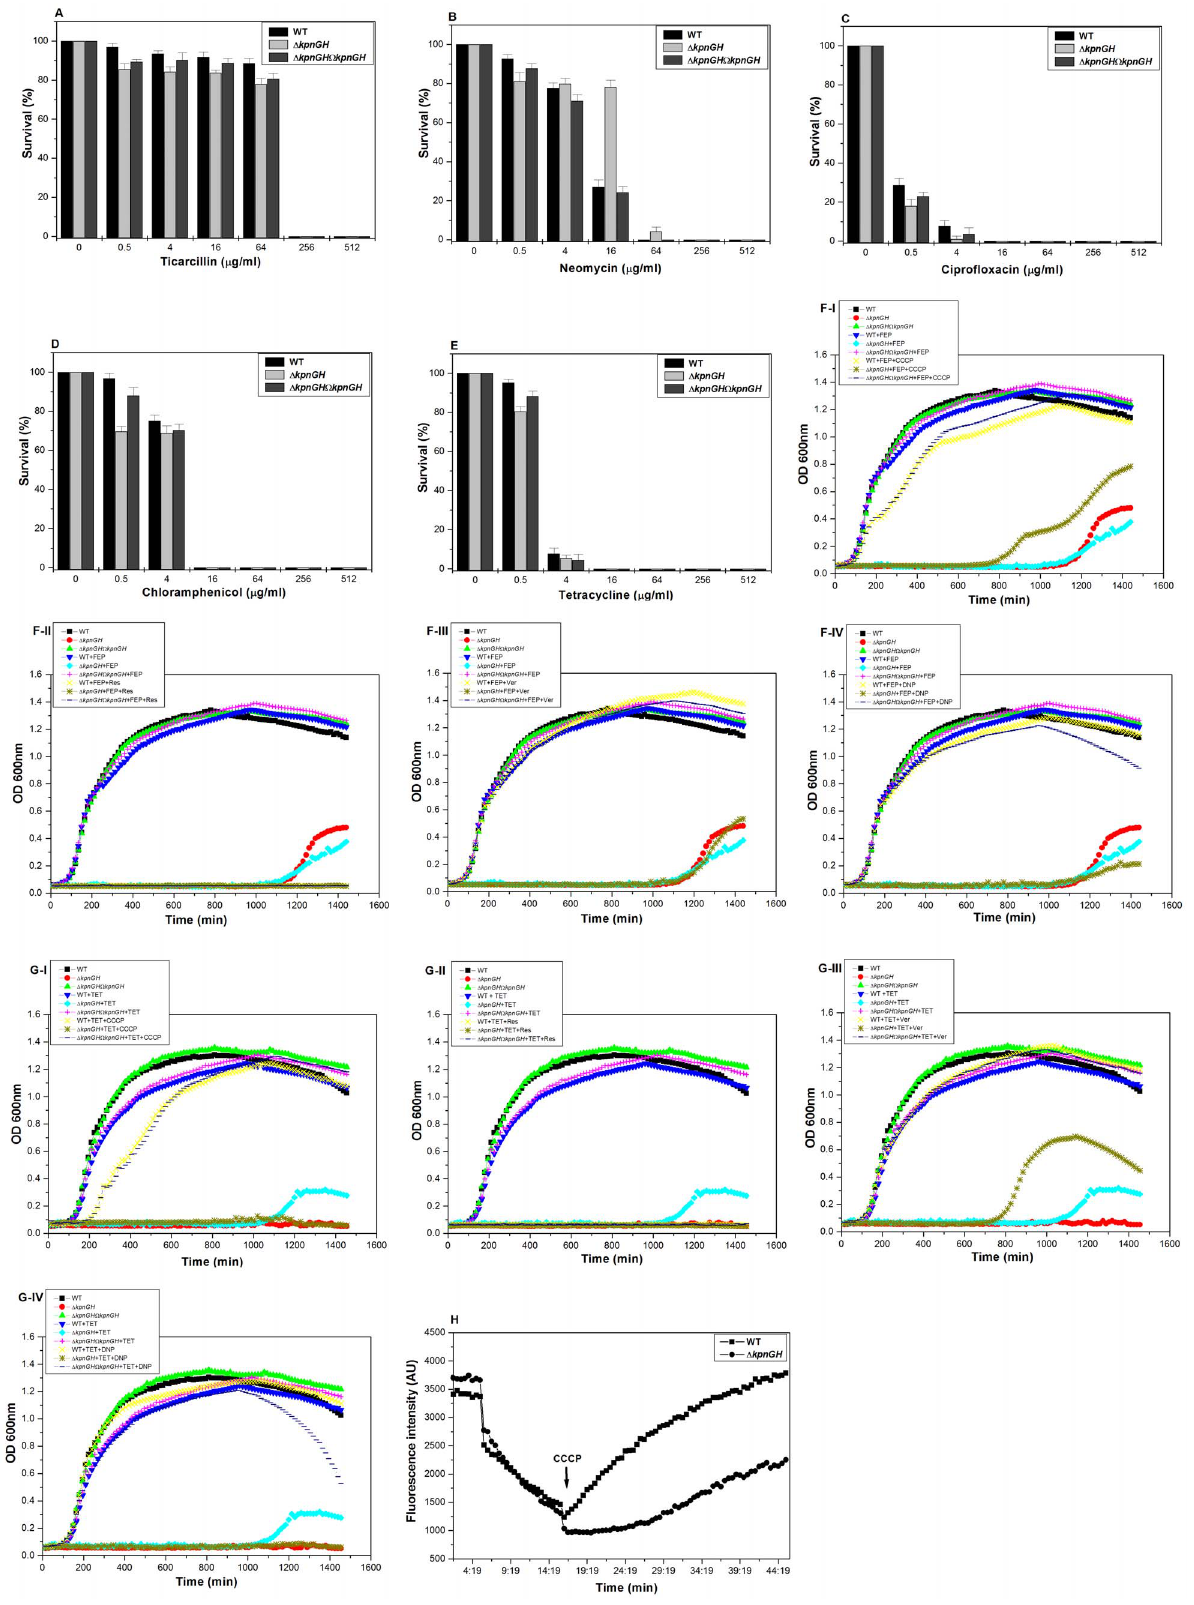
Figure 4. Susceptibility, Growth inactivation and accumulation assays towards different antibiotics. A) Sensitivity of WT, D kpnGH and D kpnGH V kpnGH towards ticarcillin. Upon exposing the cells to different concentrations of ticarcillin it was observed that the total CFU count of WT at 0.5 m g/ml was 1 fold, 4 m g/ml was 1.13 fold, 16 m g/ml was 1.11 fold, 64 m g/ml was 1.09 fold, 256 m g/ml was 1.09 fold, 512 m g/ml was 1.13 fold